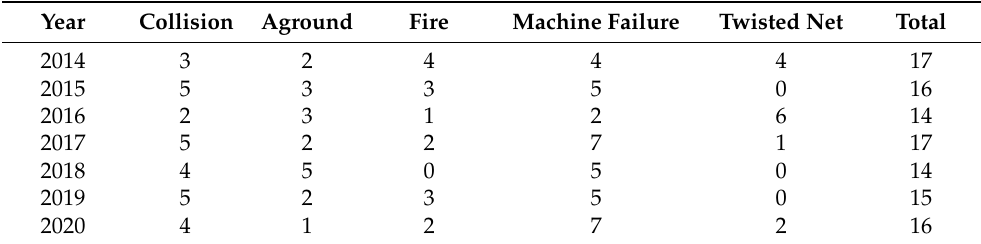
Table 2. Previous maritime accidents that occurred in the same area of the main planned offshore wind